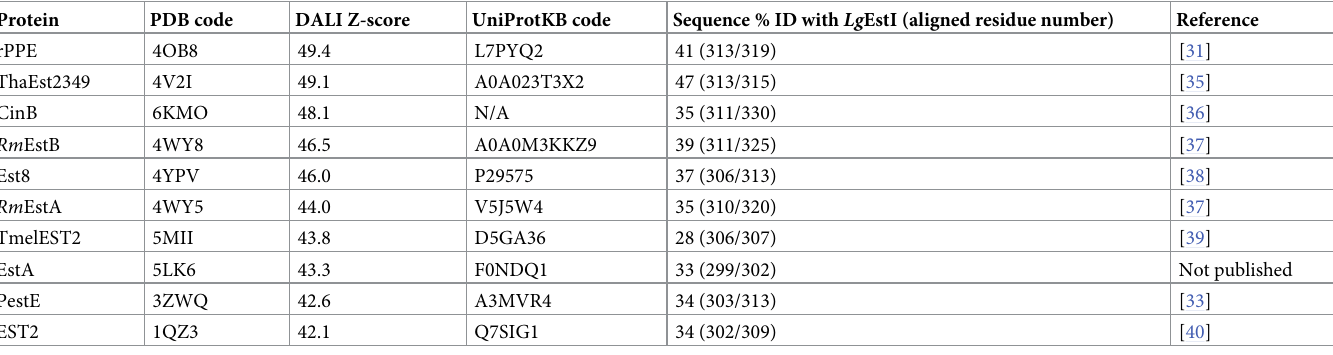
Table 1. Structural homolog search result for Lg EstI from a DALI search (DALI-Lite server). Protein PDB